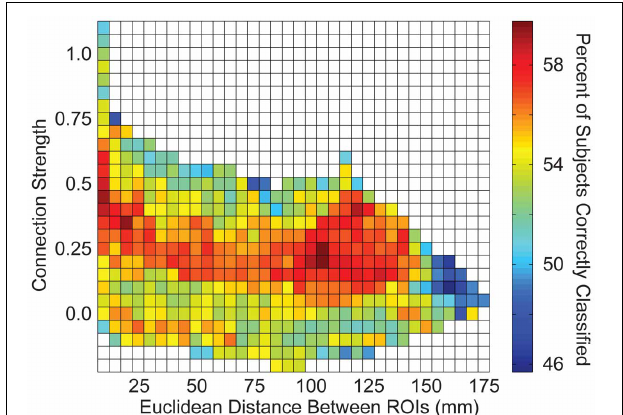
FIGURE 6 | Total accuracy across connection strength and distance between brain regions. The 26.4 million connections were divided up into bins based on the correlation strength of the connection (determined by an independent sample) and the distance between the connection’s two endpoints. Accuracy is displayed for each bin with at least one